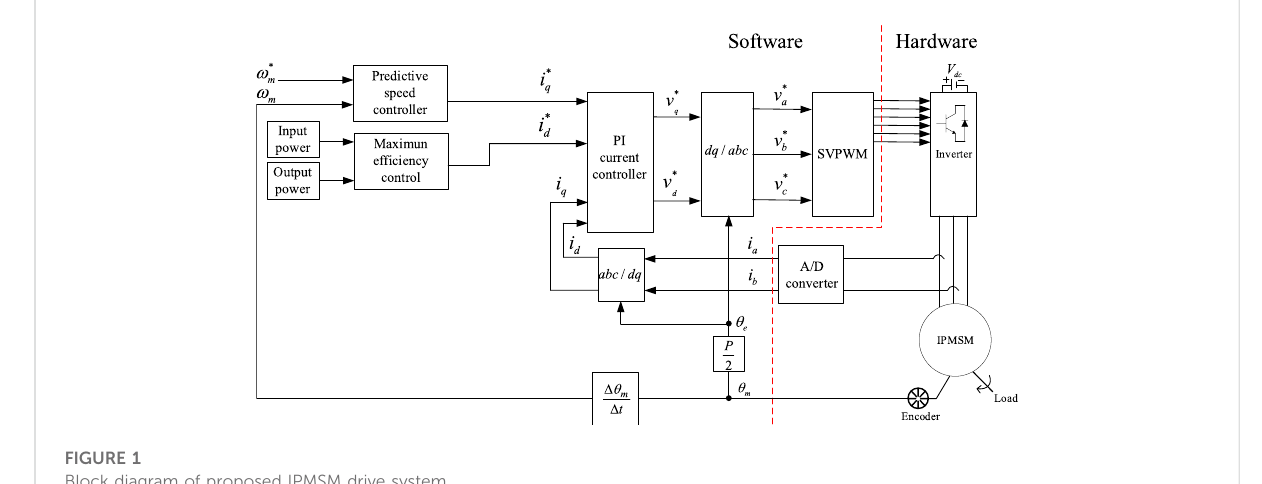
FIGURE 1 Block diagram of proposed IPMSM drive system.